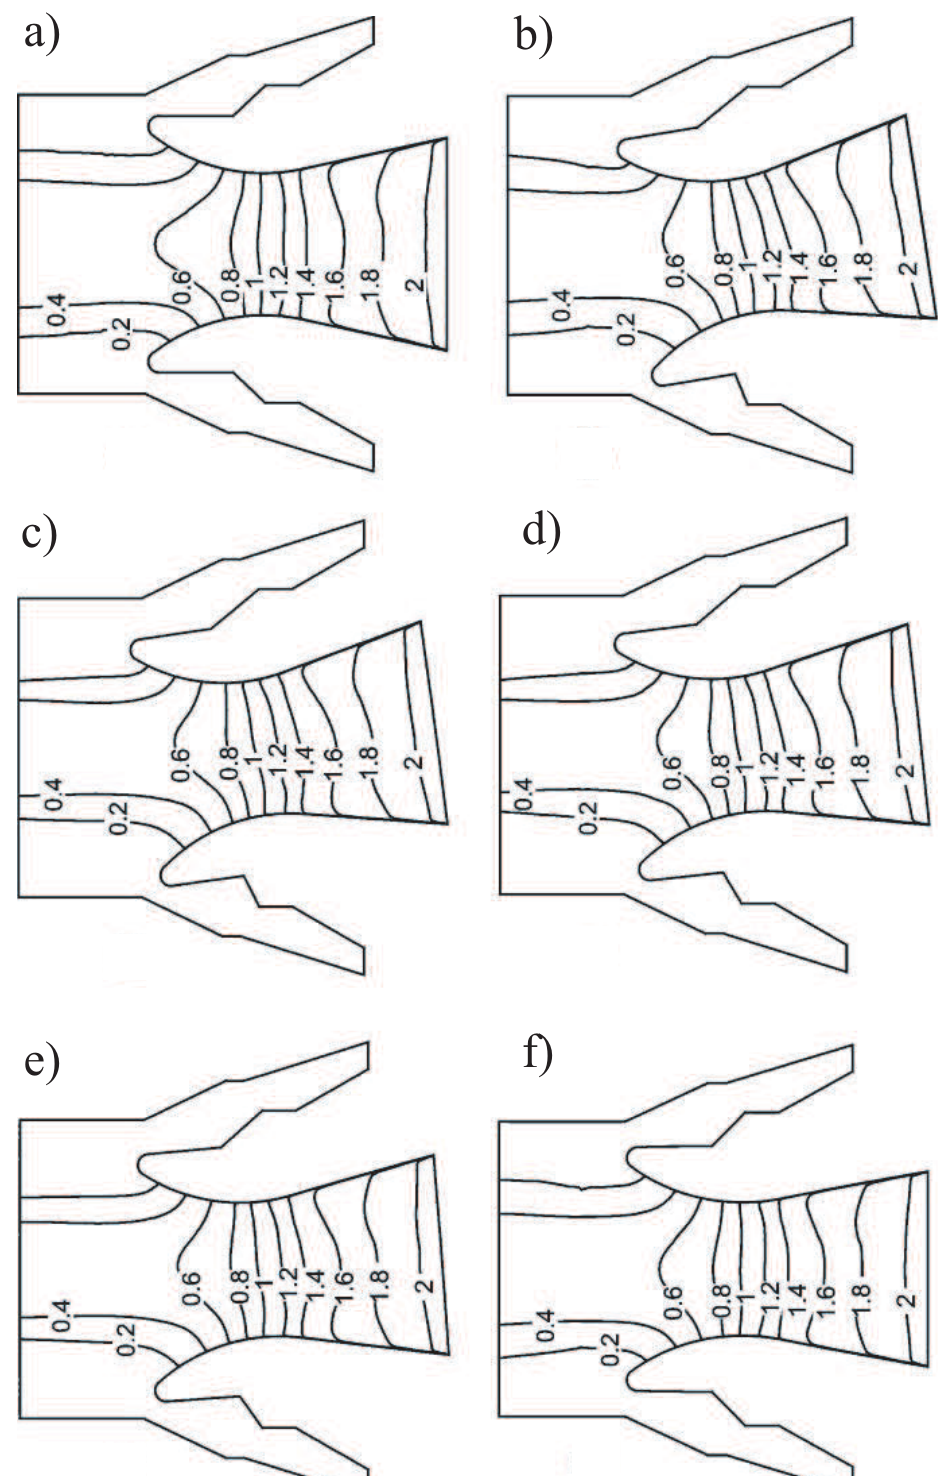
Figure 16. Contours of Mach number in nozzle for various planes for angle of nozzle rotation 9 ◦ ( a – f